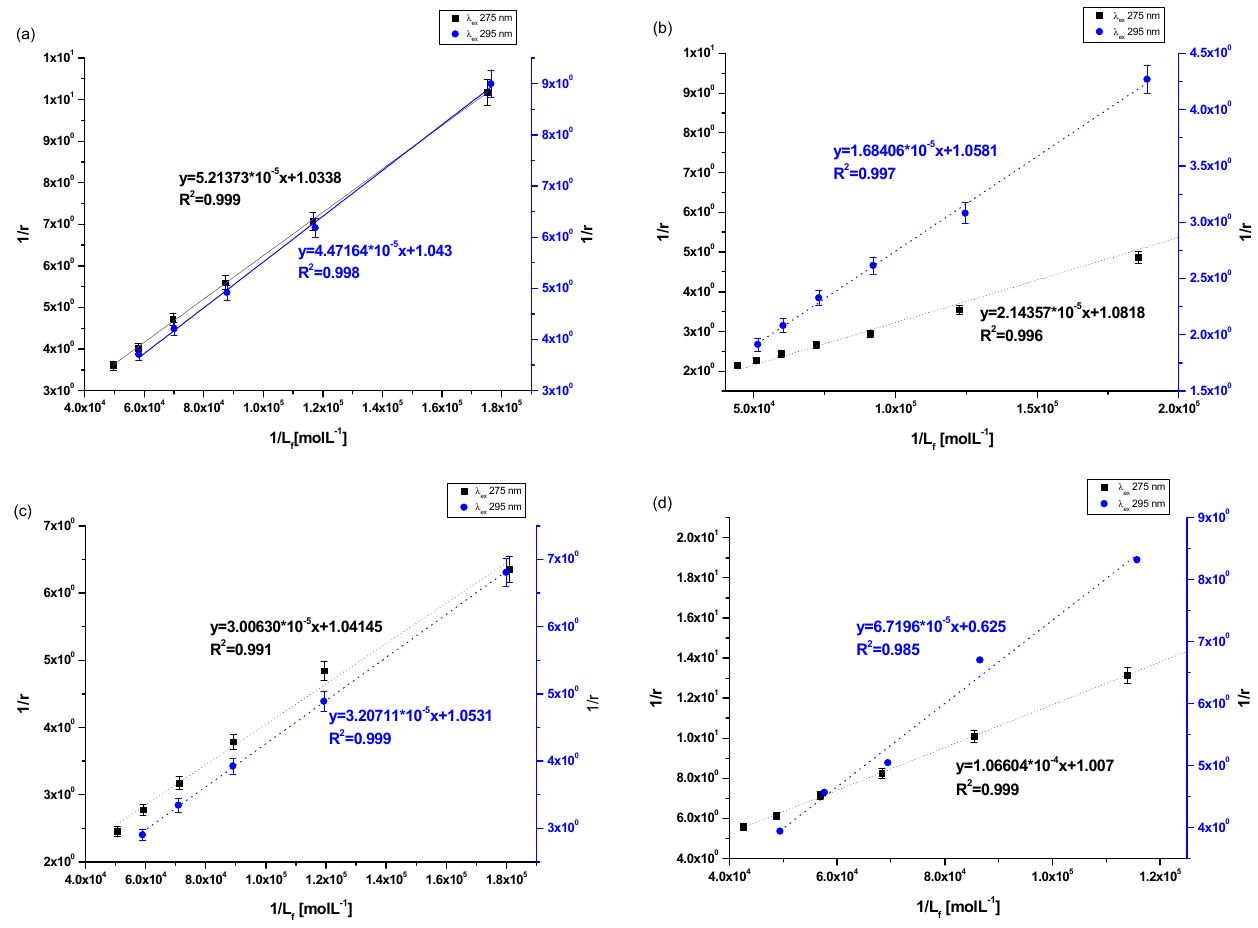
(Equation (4)), Klotz curves were plotted (Figure 5a–d) and K a values were calculated and collected in Table 5.